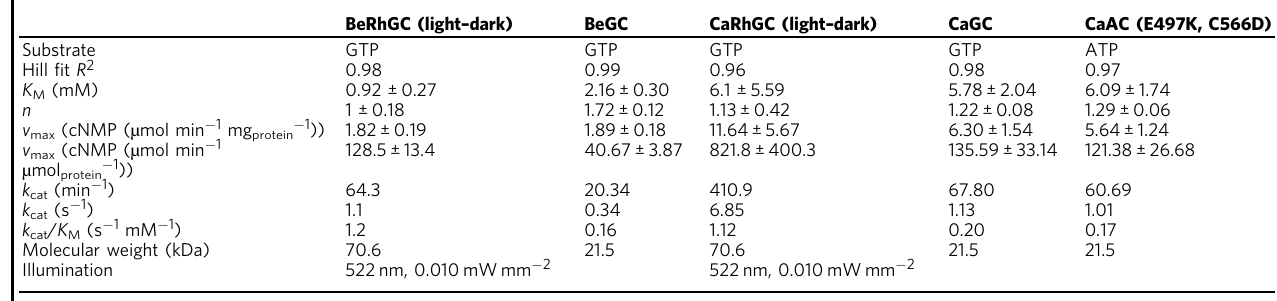
Table 1 Enzymatic parameters of puri fi ed RhGCs and truncated cyclases